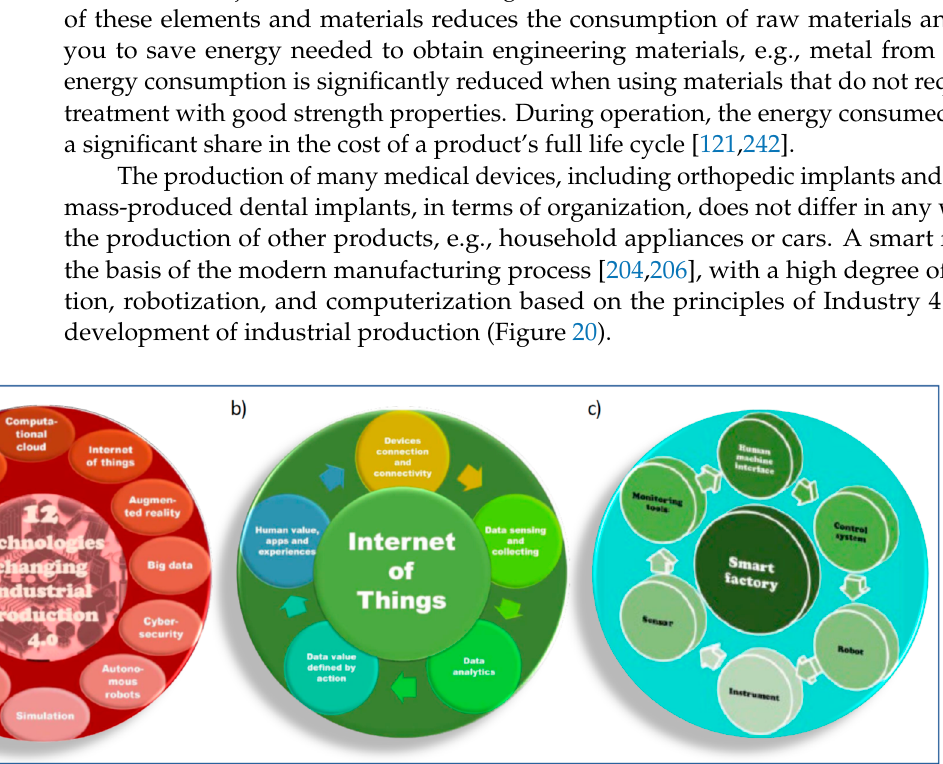
Figure 21. Diagram ( a ) relationship between the patient’s expectations, design, and manufacturing capabilities of the center for the manufacture of dental prosthetic restorations and ( b ) the medical tasks of a dental clinic according to the concept of Dentistry 4.0.